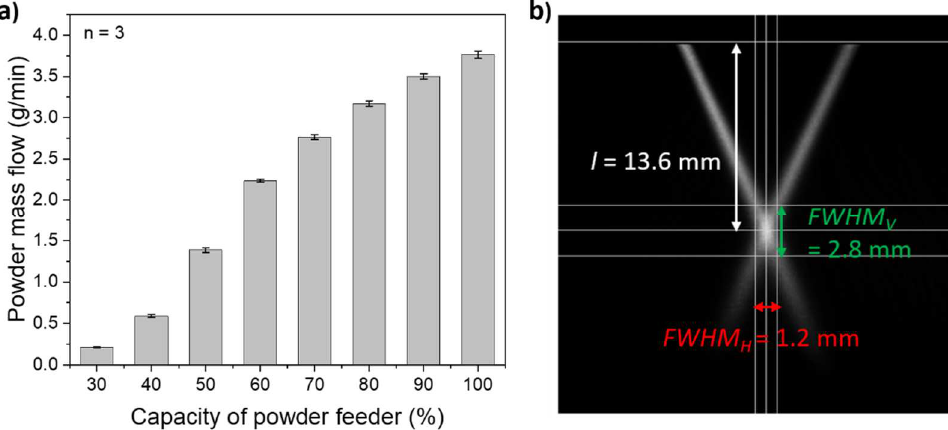
Figure 2. ( a ) Experimentally determined powder mass flow of PA12 powder depending on the capacity of the powder feeder ( n = 3); ( b ) high-speed camera analysis of the powder stream for a carrier gas flow of 6 L/min, shielding gas flow of 10 L/min and a powder mass flow of 0.6 g/min.